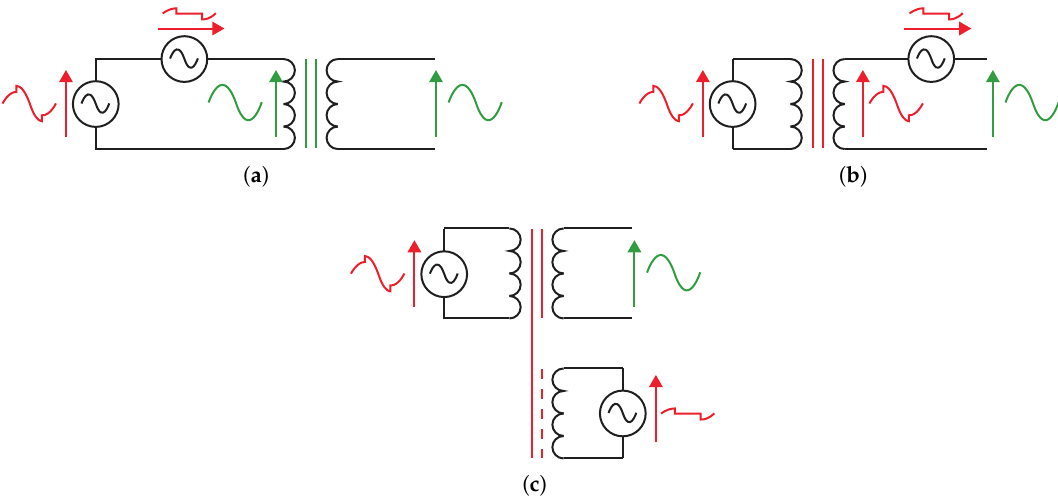
Figure 16. Series converter locations. ( a ) Primary-side. ( b ) Secondary-side. ( c ) Connected to an auxiliary